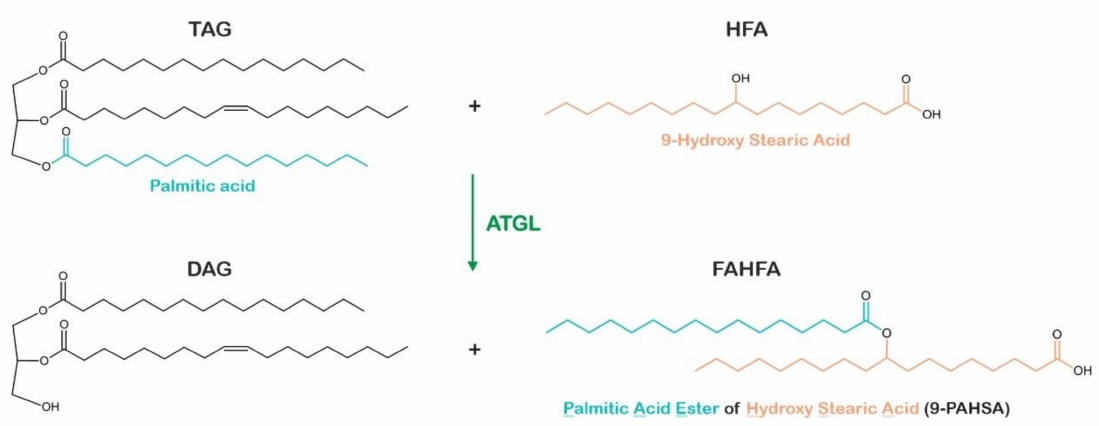
Figure 3. Generation of branched fatty acid esters of hydroxy fatty acids by transacylase activity of adipose triglyceride lipase. Adipose triglyceride lipase (ATGL) catalyzes the transfer of fatty acids (FAs, FA chain colored in blue) from triacylglycerol (TAG) or diacylglycerol (DAG) molecules onto hydroxy fatty acids (HFAs, HFA chain colored in orange), resulting in fatty acid esters of hydroxy fatty acids (FAHFAs).